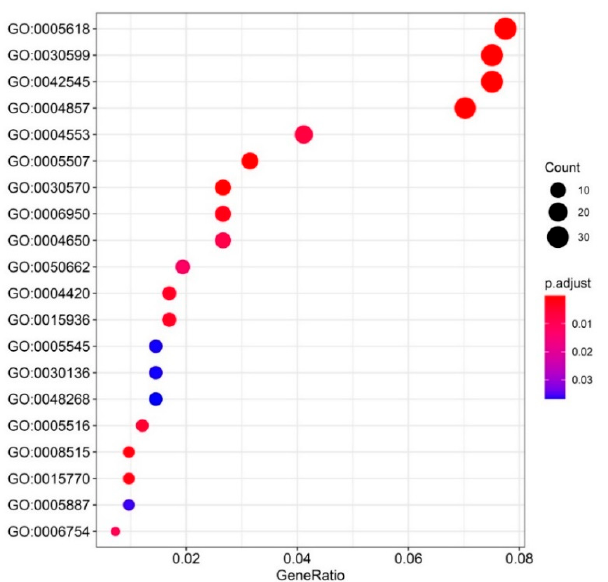
Figure 3. Gene ontology (GO) enrichment of 675 common upregulated genes of the high-altitude B. pyrosoma compared to the low-altitude B. pyrosoma using interproscan based on the amino acid sequences of common upregulated genes. GO:0005618: cell wall (cell component), GO:0004857: